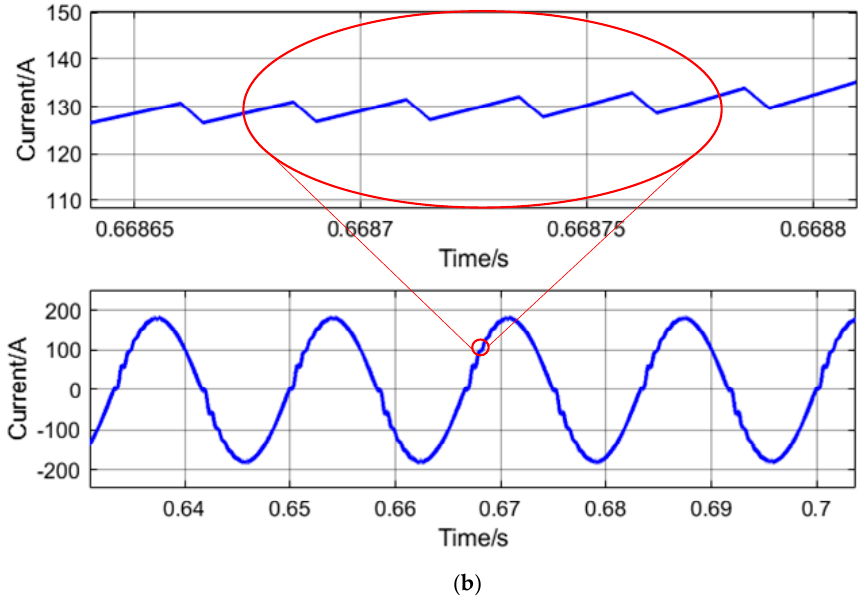
Figure 7. Simulated grid current ( a ) with same gate signal and ( b ) with interleaving gate signal.